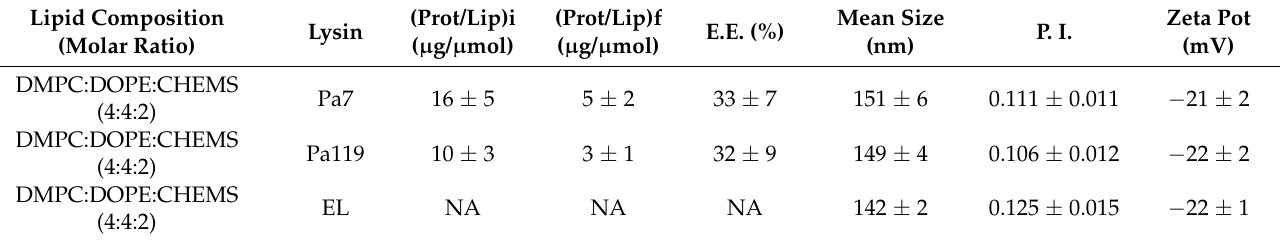
Table 4. Characterization of the liposomal